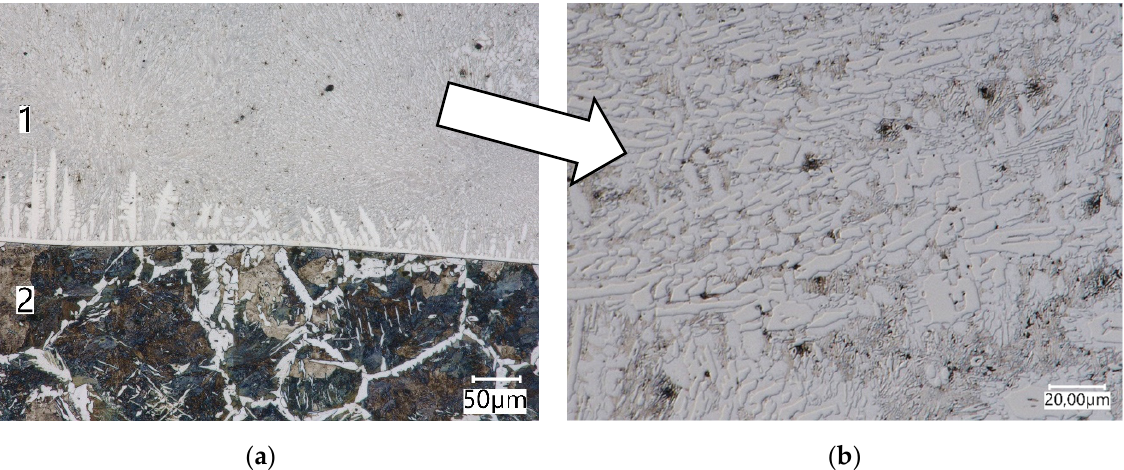
Figure 8. The microstructure of PMFe60P hardfaced layer; ( a )—fusion zone; 1 —hardfaced layer, 2 —pad layer, ( b )—hardfaced layer. Light microscopy.